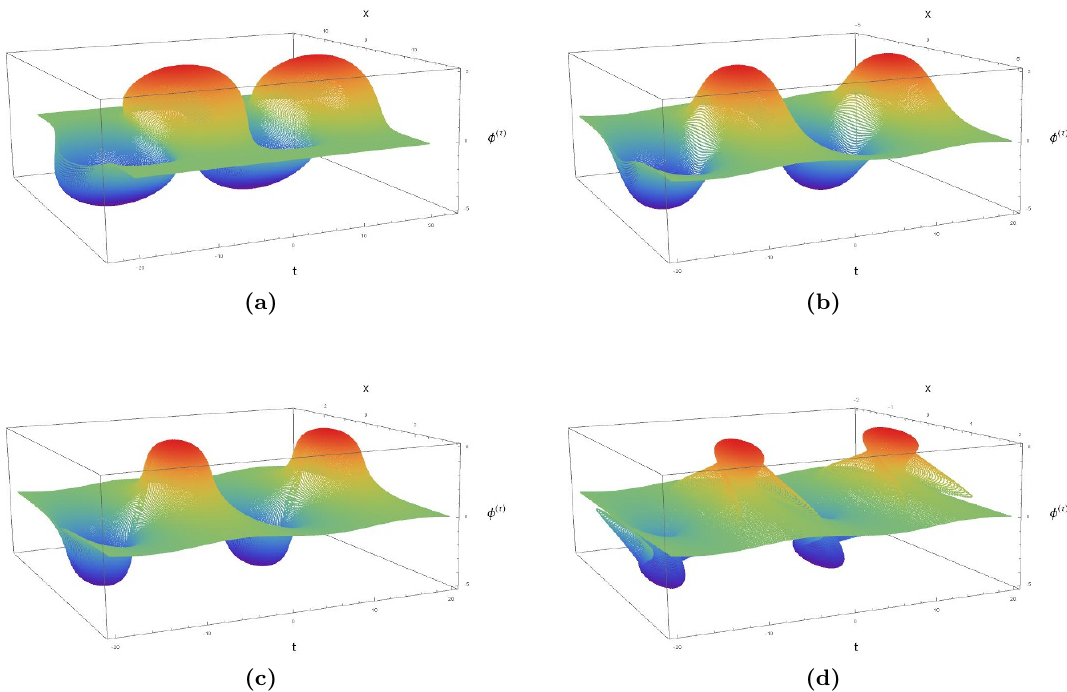
Figure 4. The T (cid:22) T -deformed stationary breather solution with envelope speed v = 0 ( m = (cid:12) = 1 ; = 2 (cid:25) ), for di(cid:11)erent values of the perturbation parameter (cid:28) . Figure 4b represents the 5 undeformed solution, (cid:12)gure 4a corresponds to (cid:28) = (cid:0) 1 = 2, while (cid:12)gures 4c and 4d correspond to (cid:28) = 1 = 10 and (cid:28) = 1 = 5,